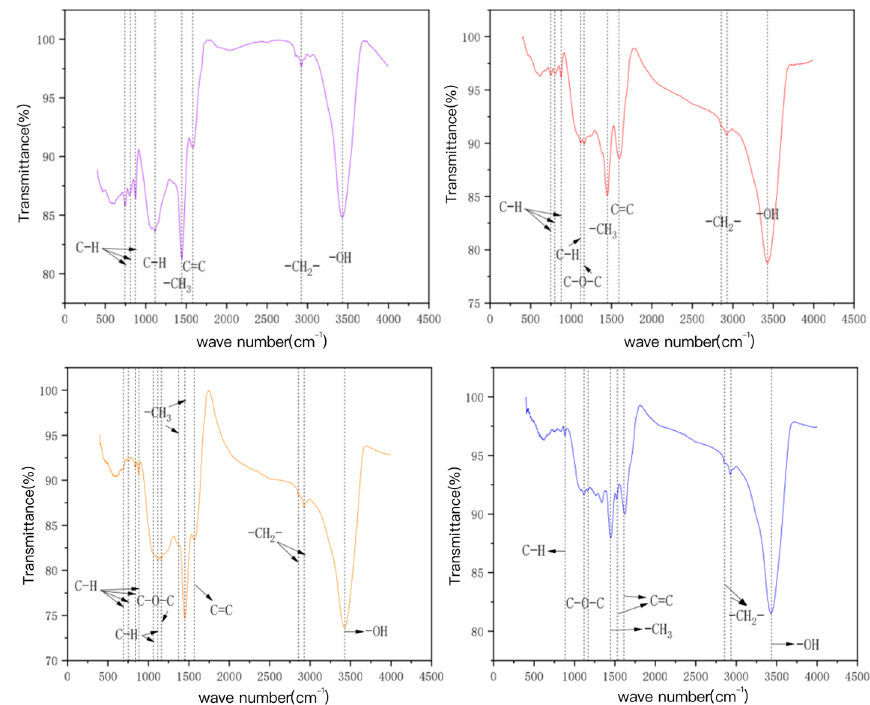
Figure 7. The FT—IR map of the bamboo charcoal and the modified bamboo charcoal.